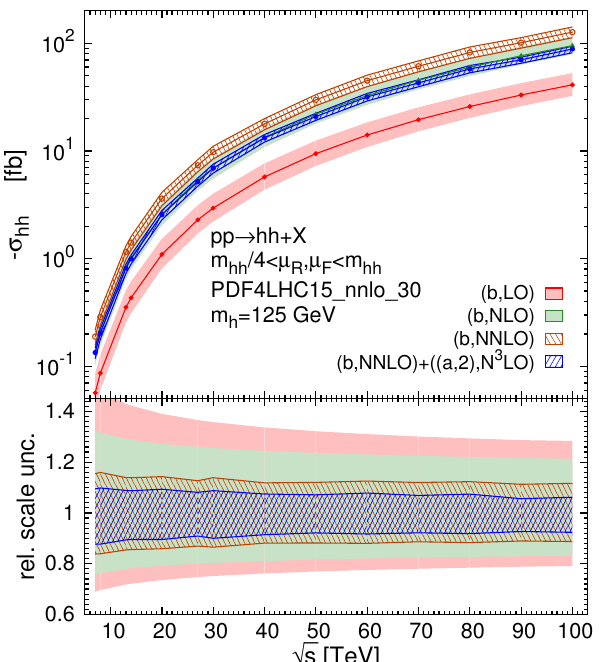
p Figure 7 . The energy s dependence of the class- b cross sections. They are LO (red), NLO 3 LO (green), NNLO (brown hatched) and NNLO plus (cid:27) ( a; 2) ; N (blue hatched). The bands represent hh the scale uncertainties. In the lower panel, we have also shown their relative scale